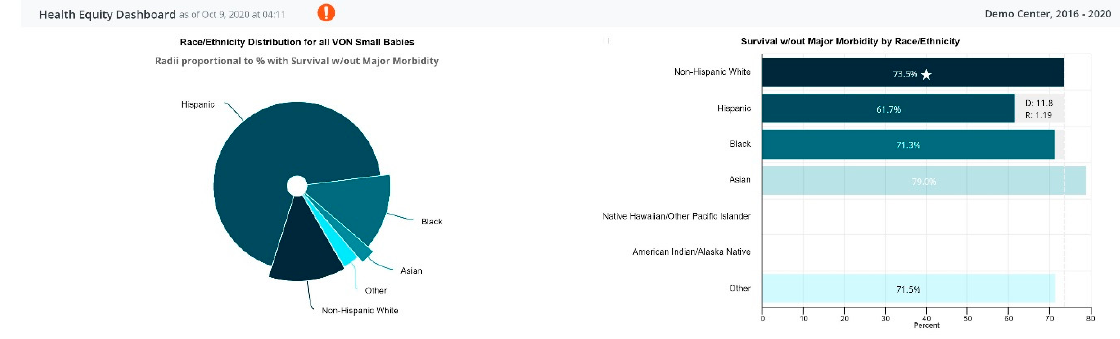
Figure 4. Sample disparity dashboard report.